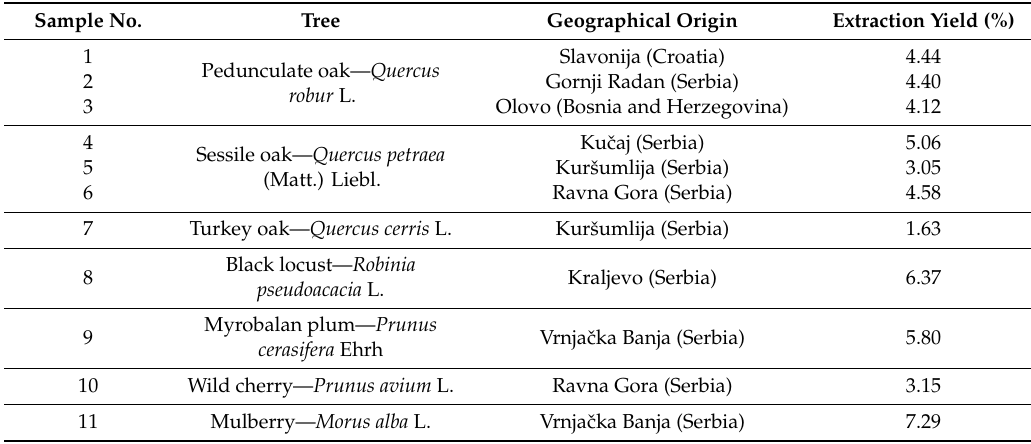
Table 1. Selected wood waste extracts of di ff erent forest trees for DPPH-HPTLC (high-performance thin-layer chromatography) and antimicrobial testing